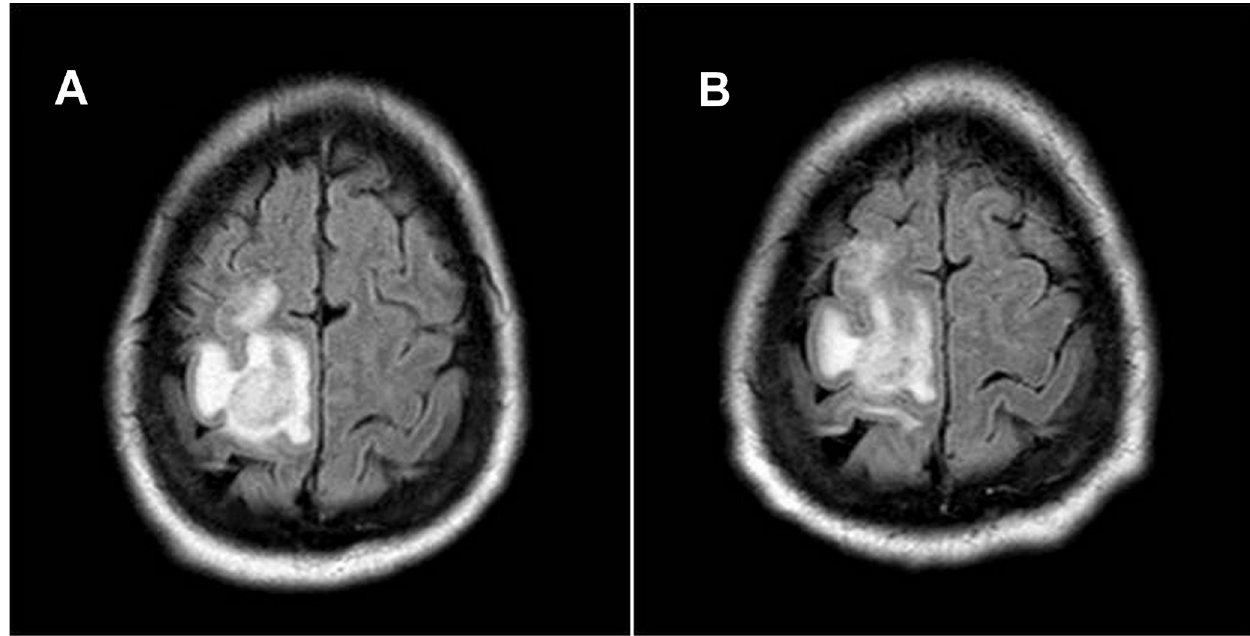
Figure 3. Brain MRI of patient 2 at presentation showed an irregular ring-enhancing lesion in the right frontoparietal region with maximal transverse dimension of 2.2 cm ( A ). After 10 days of anti-toxoplasma treatment and antiretroviral therapy, follow-up MRI revealed no significant interval change of enhancing frontoparietal lesion ( B ).